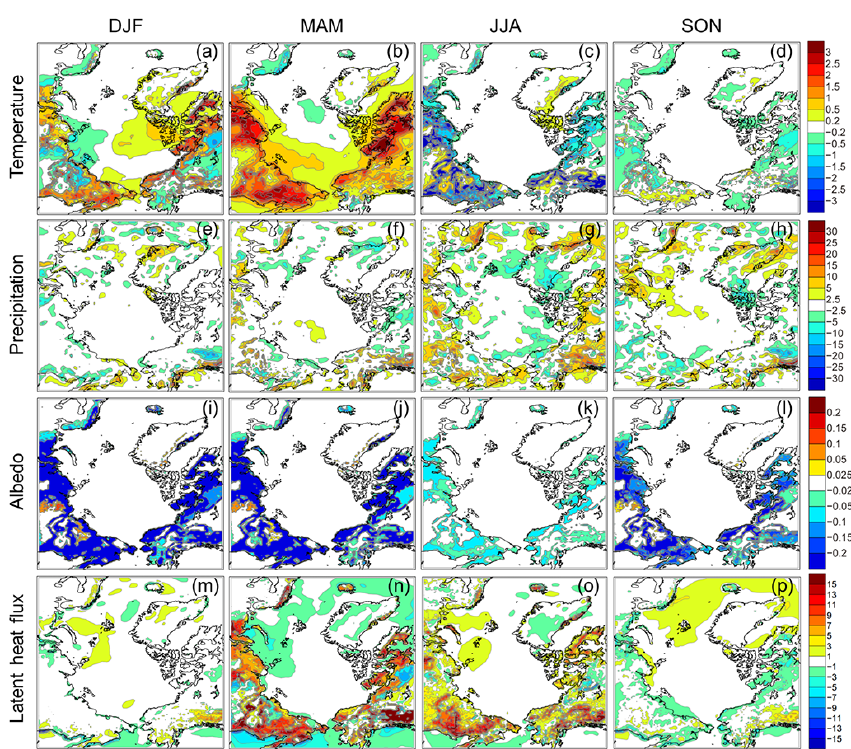
Figure 6. The effects of biogeophysical feedbacks on 2m temperature ( ◦ C) and total precipitation (mm), albedo ( − ) and latent heat flux (Wm − 2 ) on a seasonal basis, averaged from 2071–2100. ( a, e, i, m ) Winter, December to February (DJF). ( b, f, j, n ) Spring, March to May (MAM). ( c, g, k, o ) Summer, June to August (JJA). ( d, h, l, p ) Autumn, September to November